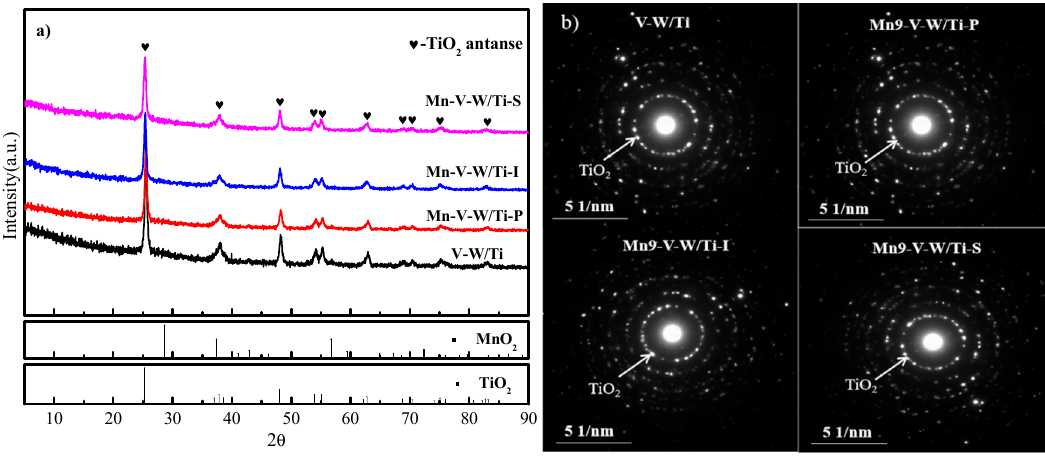
Figure 3. ( a ) XRD pattern of synthesized powder with reference peaks and ( b ) SAED pattern of V-W/Ti and Mn-V-W/Ti.